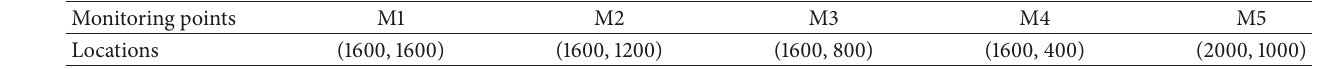
Table 2: Monitoring point locations (𝑥,𝑦) (meter, meter).